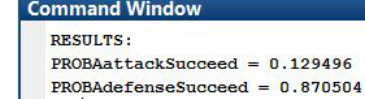
Figure 5. Probability for an attack to succeed during